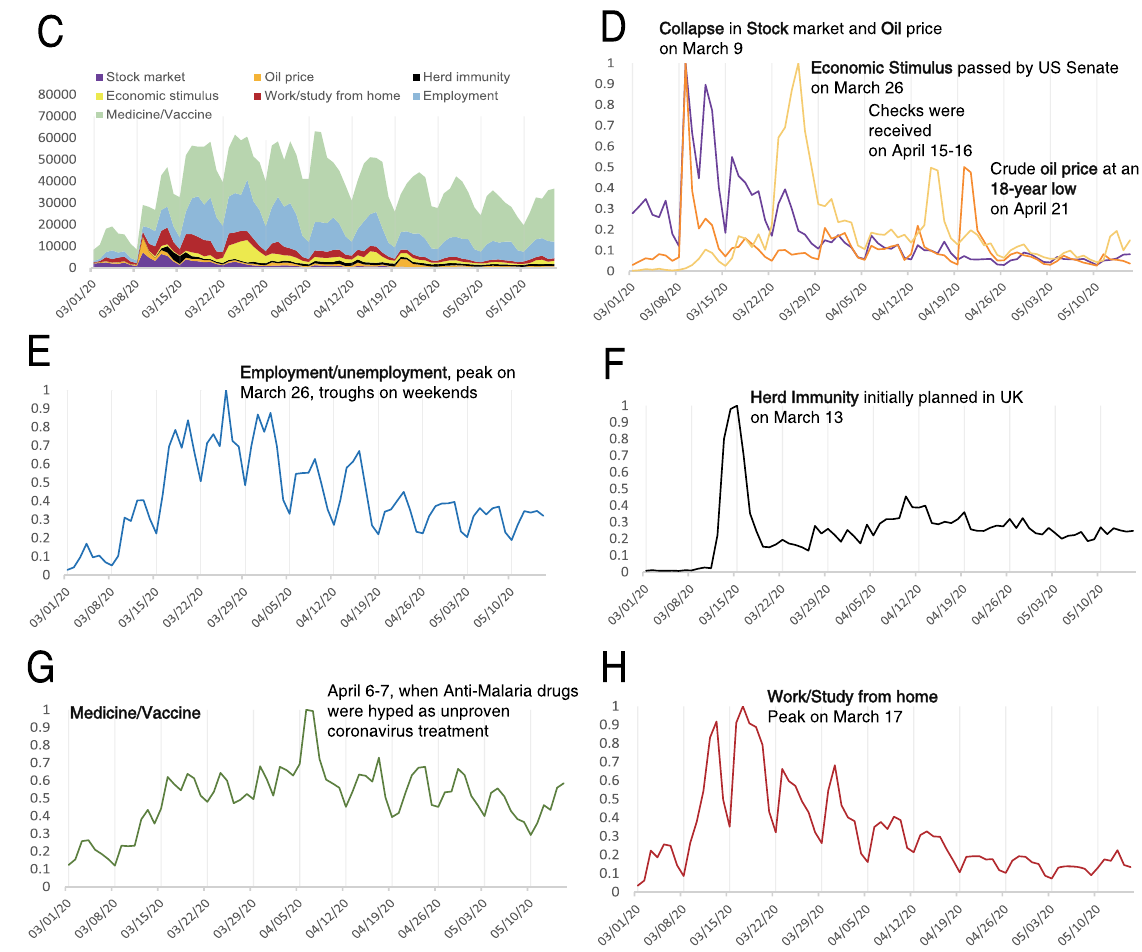
Fig. 1 Rise and fall of the global conversation of COVID-19 on social media. A Volume of COVID-19 tweets per day from March 1 to May 15, 2020 (normalized to the maximum number, with volume statistics in the insert), in English (En), Spanish (Es), Arabic (Ar), French (Fr), and Italian (It), as well as the normalized volume of COVID-19 Weibo posts per day in Chinese (Zh) from January 20 to May 15. The vertical lines show Sundays for guidance. Discussions and attention quickly reached their peak when important decisions were made, such as the announcement of a state of alarm; the imposition of national lockdowns; and the closure of leisure, business, and religious establishments, as marked out on the peaks of curves. Additionally, people ’ s attention diminished with time. High- correlation coef fi cient values ( B ) indicate that populations speaking different languages are responding similarly. C Volumes (without normalization) of English tweets per day by topic re fl ecting major citizen concerns during the COVID-19 pandemic, such as oil/stock prices, economic stimulus packages, employment, herd immunity, medicine/vaccine, and working/studying from home (normalized daily volume by maximum shown in D – H , respectively). HUMANITIES AND SOCIAL SCIENCES COMMUNICATIONS| (2021) 8:120